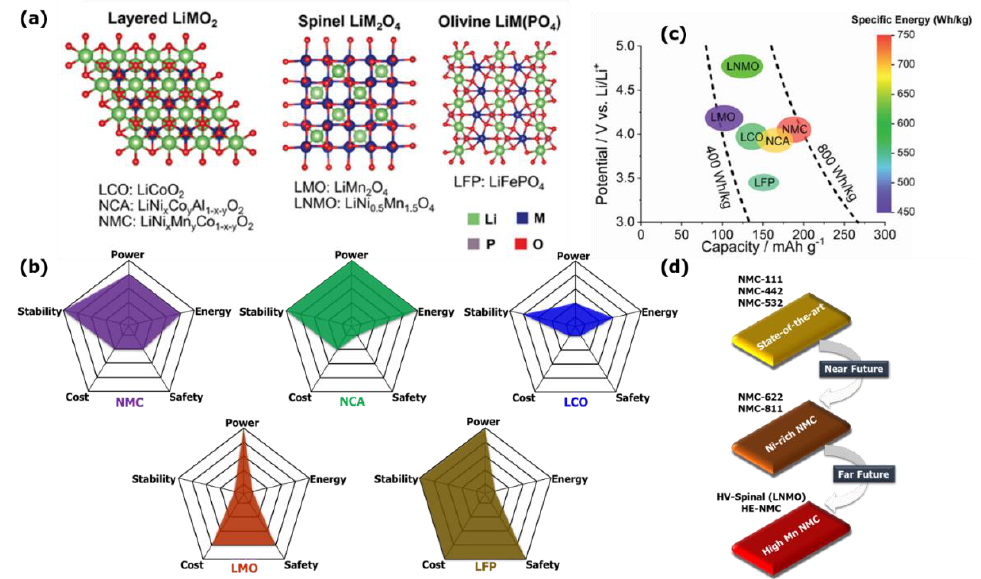
Figure 4. ( a ) Crystal structures of mainstream Li − ion cathodes such as layered (3Rm), spinel (Fd − 3m), and olivine (Pnma) systems (viewed along the a − axis). ( b ) Radar summary of the features for the most common cathodes. ( c ) Operating potential, specific capacity, and specific energy of several such cathodes. ( d ) Schematic of the state-of-the-art NMC cathode materials, near-future NMC materials, and far-future NMC series materials. ( a − c ) reprinted with permission from [10]. Copyright 2022, John Wiley and Sons, Inc. Table 1. Various lithium-ion battery chemistries for EVs. LTO: Li 4 Ti 5 O 12 , C: graphite; Si: